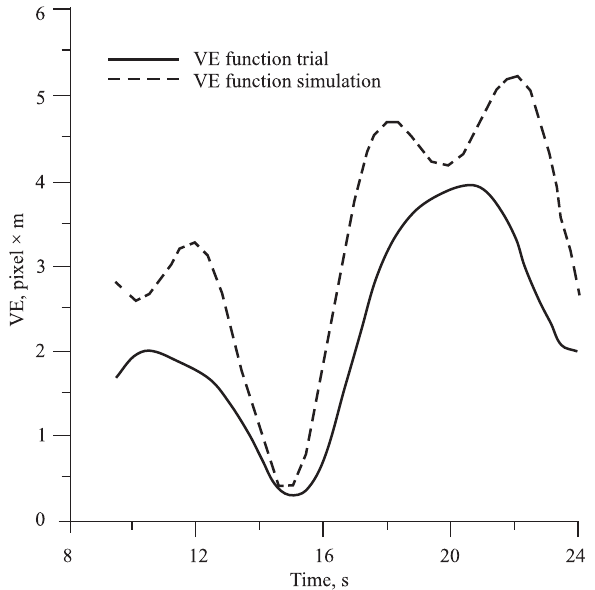
Fig. 10. Comparison of the Visual Energy between the original and simulated scenarios in the section 200 – 450 in relationship with the time